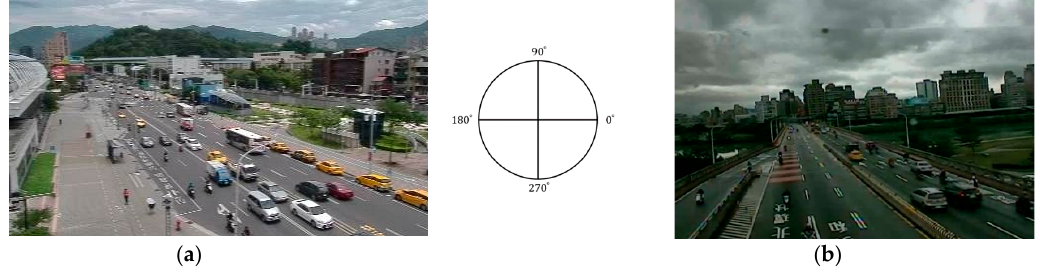
Figure 3. Two examples of defining the traffic directions based on the traffic flow in the traffic lanes near the camera: ( a ) the range of the incoming direction is defined from 140° to 170°, and that of the outgoing direction is defined from 290° to 340°; ( b ) the range of incoming and outgoing directions are defined from 130° to 160° and from 230° to 320°, respectively.